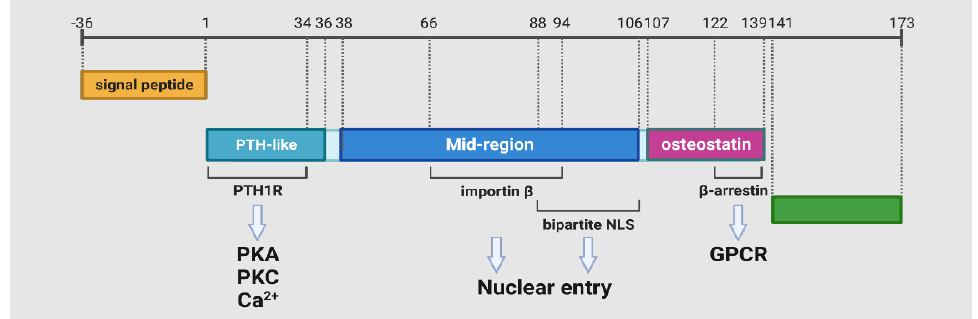
Figure 1. The functional domains of the PTHrP protein. The signal peptide module serves to dock the nascent peptide to the secretory pathway. “PTH-like” indicates the receptor-binding region, and “Mid-region” contains the bipartite NLS essential for PTHrP nuclear import; the C-terminal domains include “osteostatin”, which is involved in bone turnover and β-arrestin binding. The green region is part of the C-terminal that only exists in PTHrP 1–173 [61]. PTH: parathyroid hormone; PTHrP: parathyroid hormone-related protein; PKA: protein kinase A; PKC: protein kinase C; NLS: nuclear localization signals; GPCR: G-protein-coupled receptors.